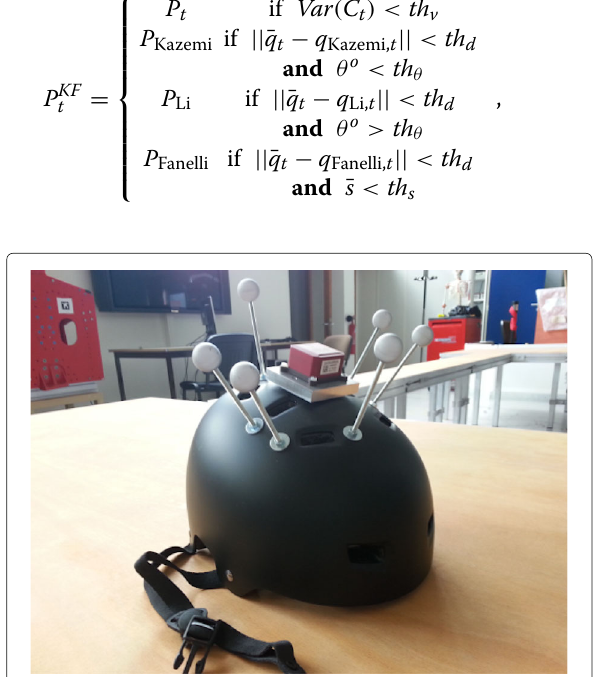
Fig. 6 Helmet used for the acquisition of the ground